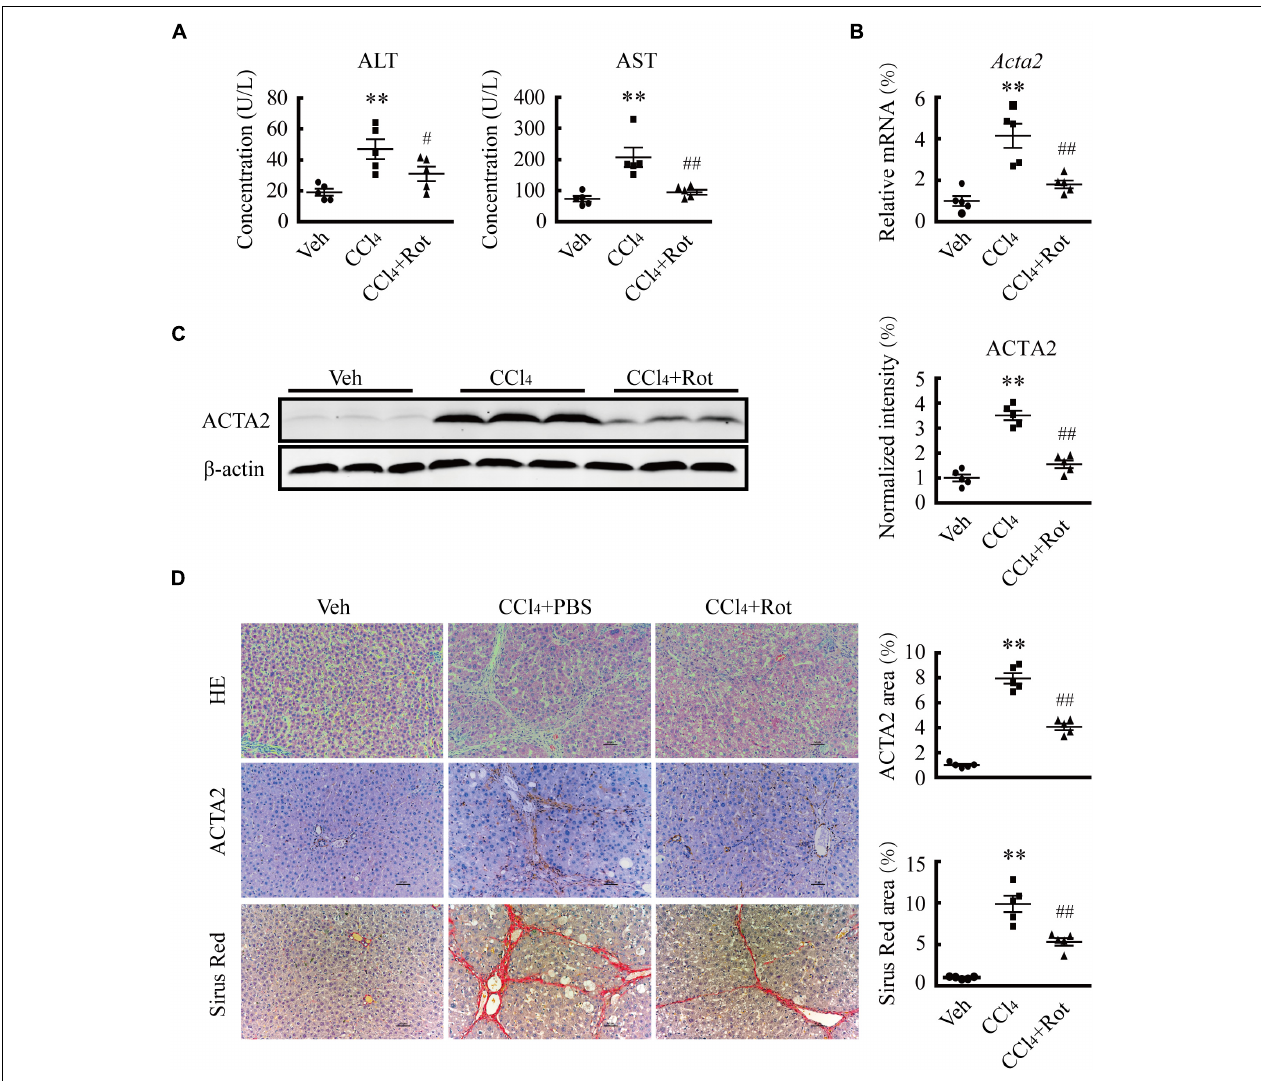
FIGURE 4 | Treatment with the large-conductance and Ca 2 + -activated K + (BK) channel activator rottlerin ameliorates CCl 4 -induced liver fibrosis in vivo. (A) Serum levels of alanine transaminase (ALT) and aspartate transaminase (AST) from rats in the indicated groups ( ∗∗ p < 0.01 compared with the vehicle (Veh) group, # p < 0.05 and ## p < 0.01 compared with the CCl 4 -treated group, n = 5). (B) Relative mRNA levels of ACTA2 in the liver tissue of rats subjected to the indicated treatments ( ∗∗ p < 0.01 compared with the Veh group, ## p < 0.01 compared with the CCl 4 -treated group, n = 5). (C) Representative western blots ( left ) and normalized intensity ( right ) of the indicated ACTA2 protein levels in rats subjected to the indicated treatments ( ∗∗ p < 0.01 compared with the Veh group, ## p < 0.01 compared with the CCl 4 -treated group, n = 5). (D) Representative images of liver sections stained with hematoxylin and eosin (H&E), anti-ACTA2 antibody, and Sirius Red ( left ) and quantification of the positive area ( right ), in rats subjected to the indicated treatments ( ∗∗ p < 0.01 compared with the Veh group, ## p < 0.01 compared with the CCl4-treated group, scale bar: 50 µ m, n =